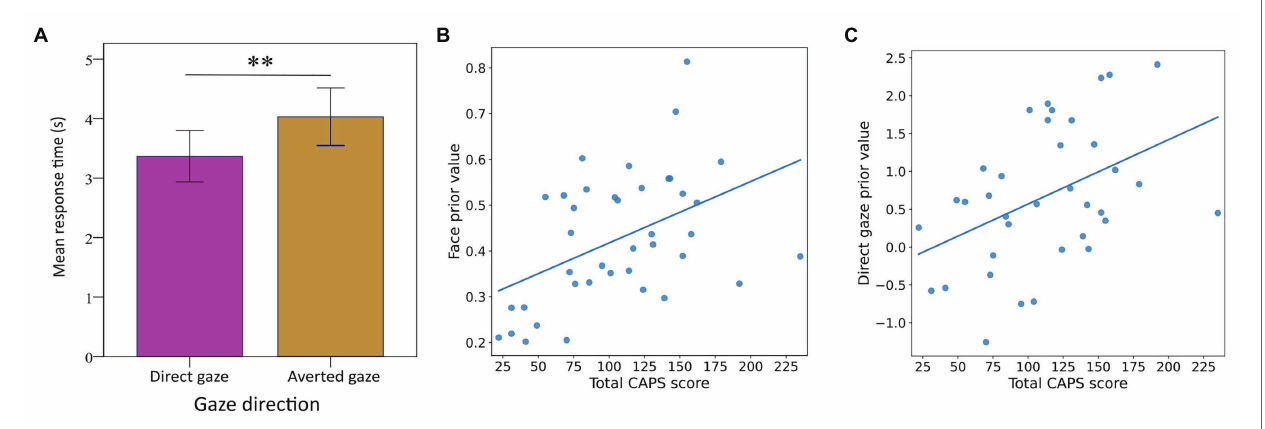
FIGURE 3 | Mean response times for direct and averted gaze in the unconscious gaze task (A) . Consistent with previous studies, response times were significantly faster for direct gaze ( T = − 4.362, p < 0.001). Relationships between participants’ hallucination proneness (CAPS scores) and signal detection bias in the face task (B) and direct gaze bias in the unconscious gaze task (C) . With growing hallucination proneness, participants show an increased readiness to detect faces in noise and actual face stimuli (rho = 0.500, p = 0.001) as well as to unconsciously process direct gaze faster than averted gaze (rho = 0.424, p = 0.010). ** p <